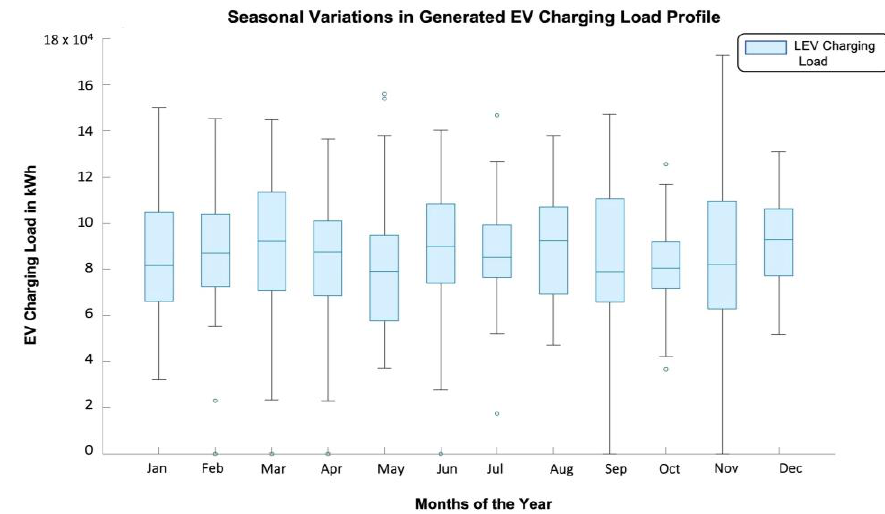
Figure A2. Charging profile with seasonal variations with different months of the year.